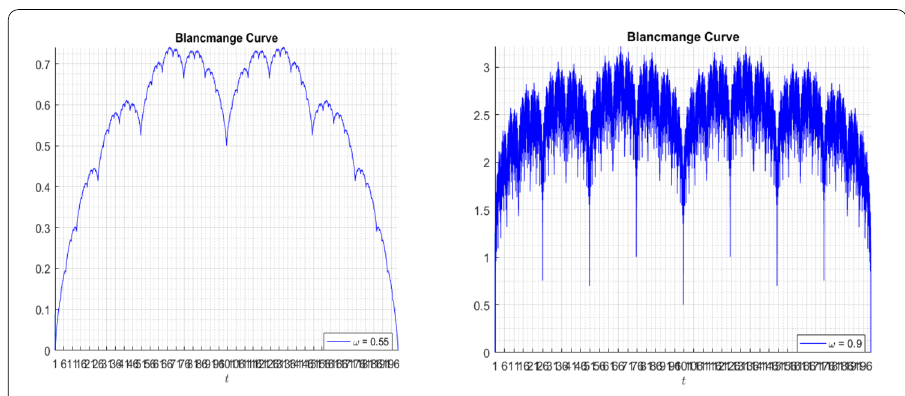
Figure 21 Blancmange function c =